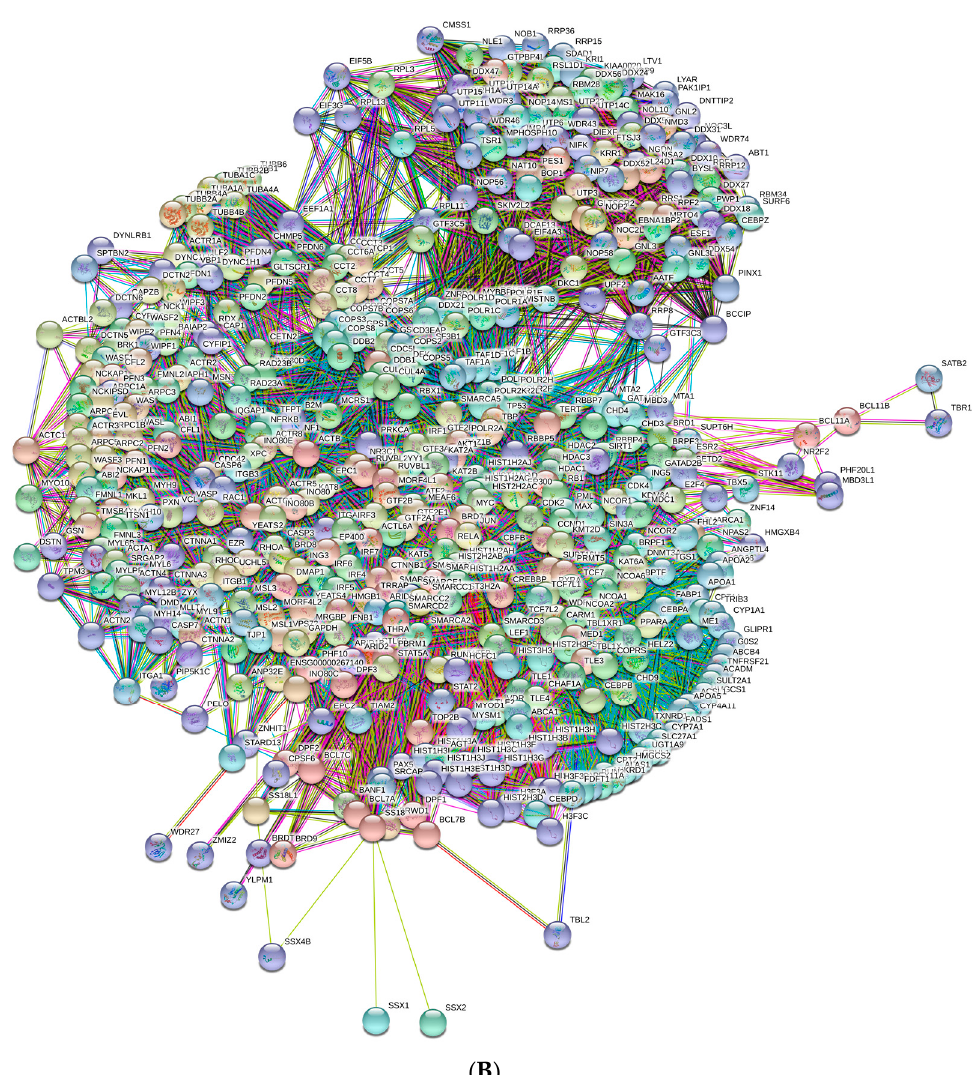
Figure 4. Evaluation of the interactability of human BAF subunits by the STRING platform. ( A) Network of the inter-complex protein–protein interactions (PPIs; 30 subunits, low confidence level of 0.15). ( B ) BAF-centered PPI network (530 proteins, high confidence level of 0.7).